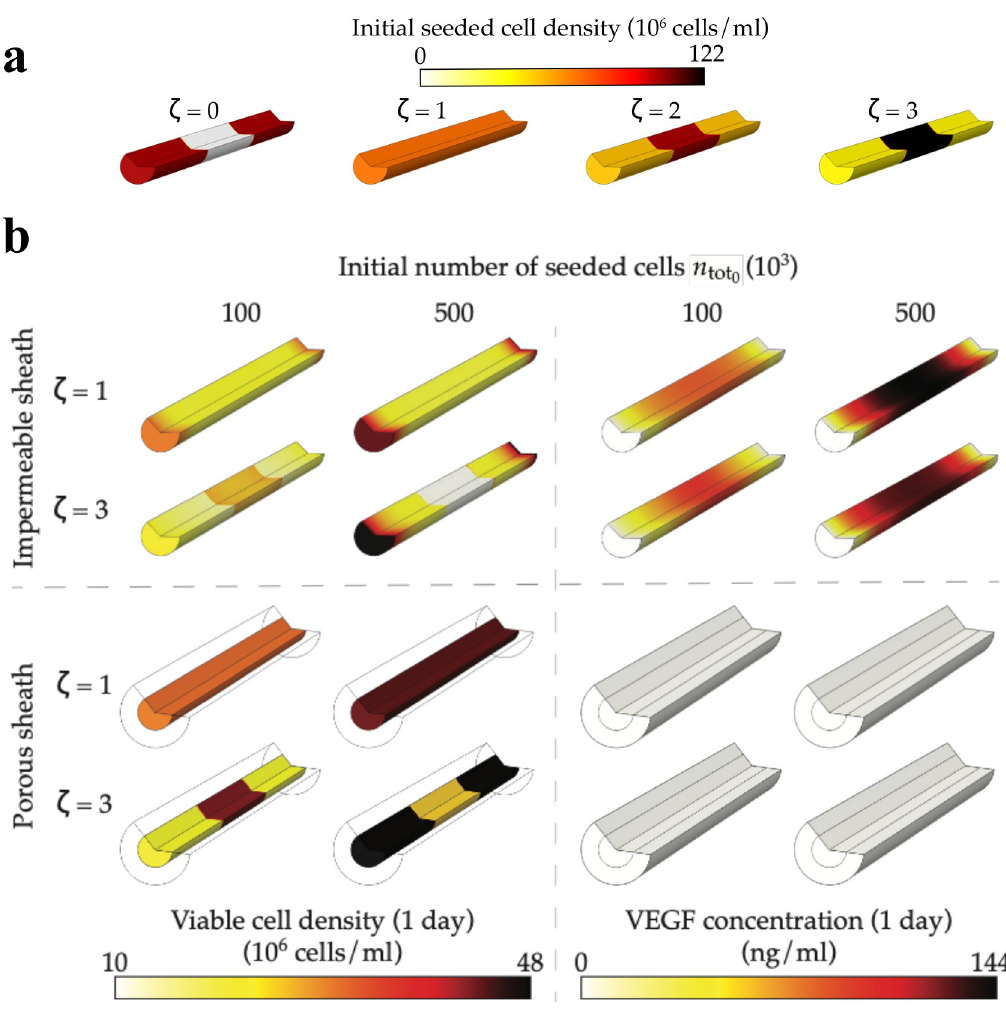
2 × 10 5 cells. The case z = 1 corresponds to a uniform distribution. B) Heatmaps of cell density (left) and VEGF concentration (right) for impermeable (top) and porous (bottom) sheaths after 1 day. In each panel, simulations are run for two different values of z and n 0,total . When porous, the sheath structure is approximated by an array of overlapping spheres (see Table 1) with a thickness T = 0.25mm and a porosity � =